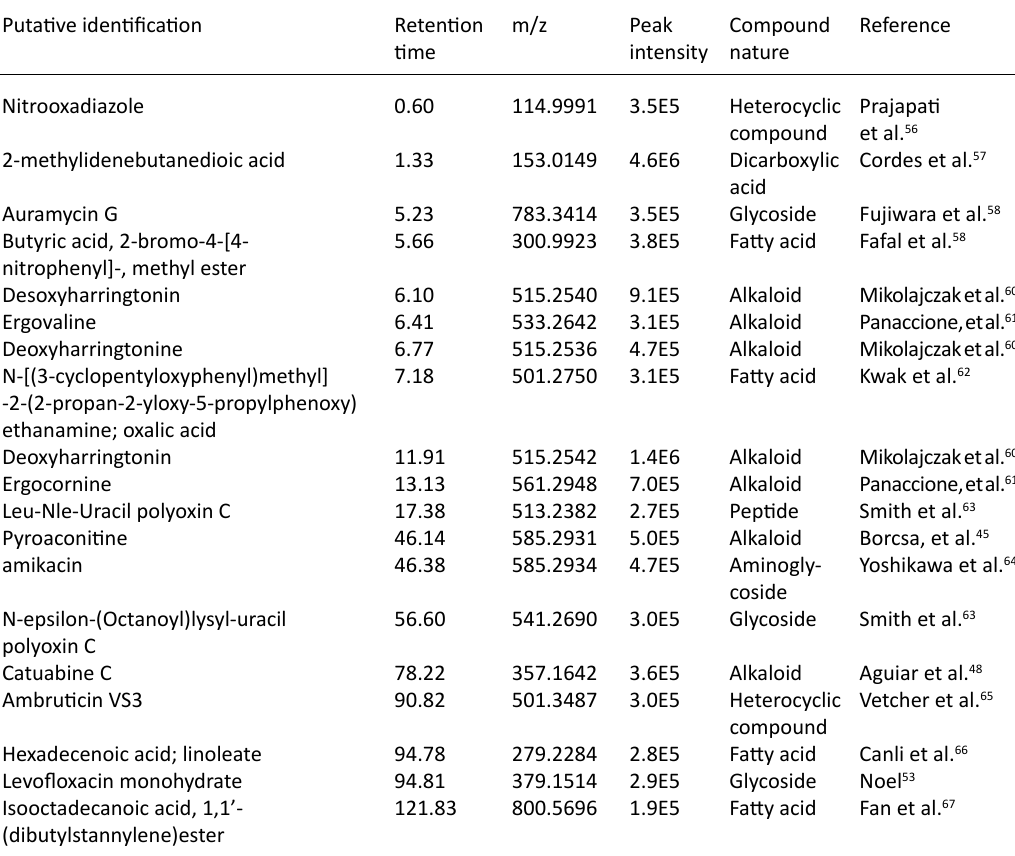
table 5. Putative compounds identification of ethanol crude extract of G. boninense from PubChem by HPLC coupled with electrospray ionization mass spectrometry system Putative identification